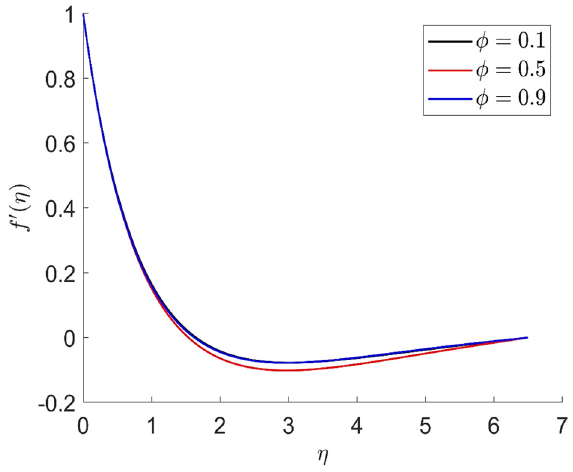
Figure 11. Representation of radial velocity f ′ (η) for the different values of φ with R = 3, n = 3, v = 0.8, m = 3.5, Pr = 0.7, φ 1 = 0.2, φ 2 = 0.4, β 3 = 0.6, β = 0.4, β 1 = 0.3, β 2 = 0.5, u = 0.4, ξ = 0.4.